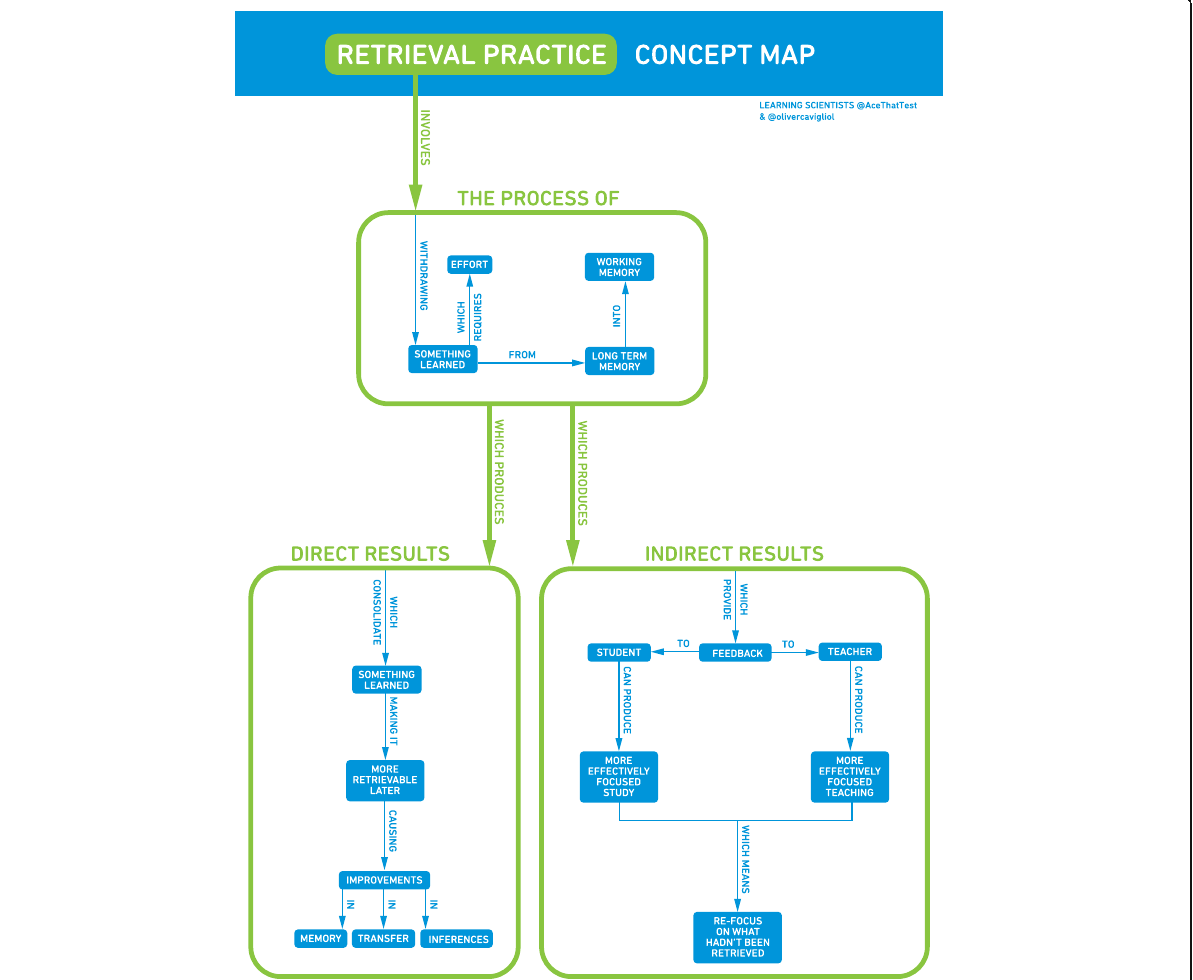
Fig. 3 Concept map illustrating the process and resulting benefits of retrieval practice. Retrieval practice involves the process of withdrawing learned information from long-term memory into working memory, which requires effort. This produces direct benefits via the consolidation of learned information, making it easier to remember later and causing improvements in memory, transfer, and inferences. Retrieval practice also produces indirect benefits of feedback to students and teachers, which in turn can lead to more effective study and teaching practices, with a focus on information that was not accurately retrieved. Copyright note: this figure originally appeared in a blog post by the first and third authors